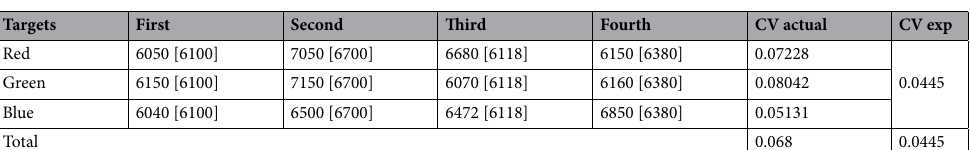
Table 2. Repeatability testing on specimen holder cutting-forward distances (µm) calculated from the sectioning-guided models (expected) and measured in paired data-in models (actual), and the coefficients of variation (CV) from four runs in different periods. Comparisons between the expected (in brackets) and actual values with Student’s paired T-tests produce no statistical significance (N = 12, p > 0.192 of 2-tailed). The numerals without brackets indicate the actual values measured in data-in